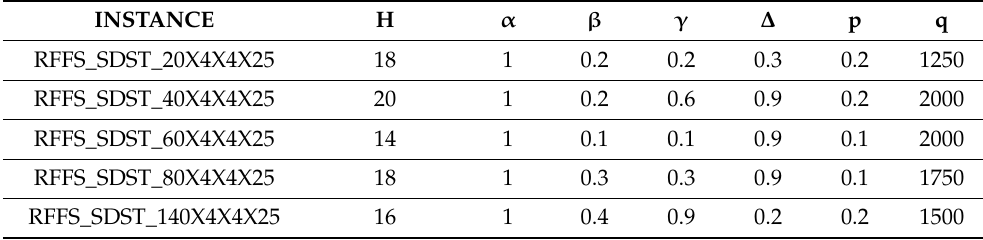
Table 5. ACS tuning